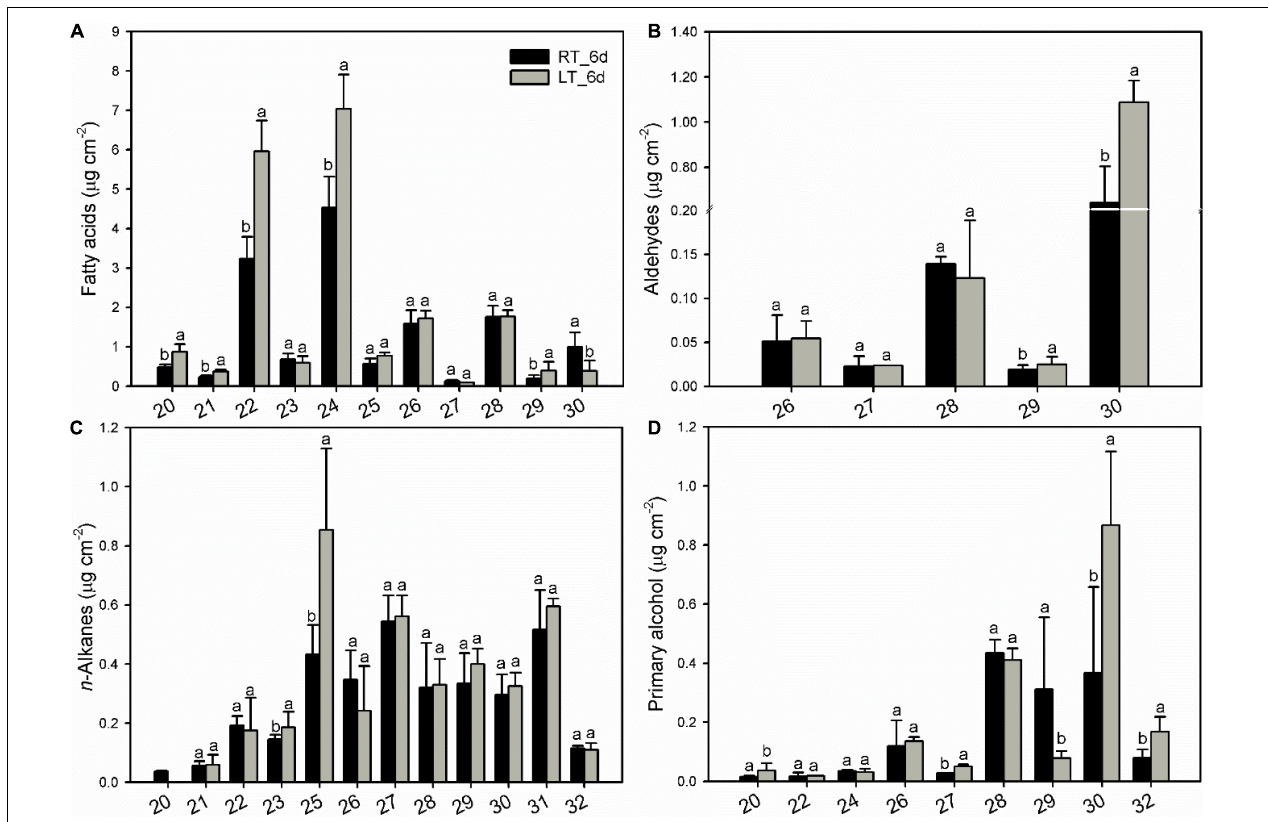
FIGURE 5 | Changes in chain-length distribution and content of variety aliphatics in banana fruit cuticle stored under 4 ◦ C (low temperature, LT) and 25 ◦ C (room temperature, RT) at 6 days. (A) Fatty acids; (B) aldehydes; (C) n -alkanes; and (D) primary alcohols. Data are given as means ± SD ( n = 5). Letters indicate the significant differences at the 0.05